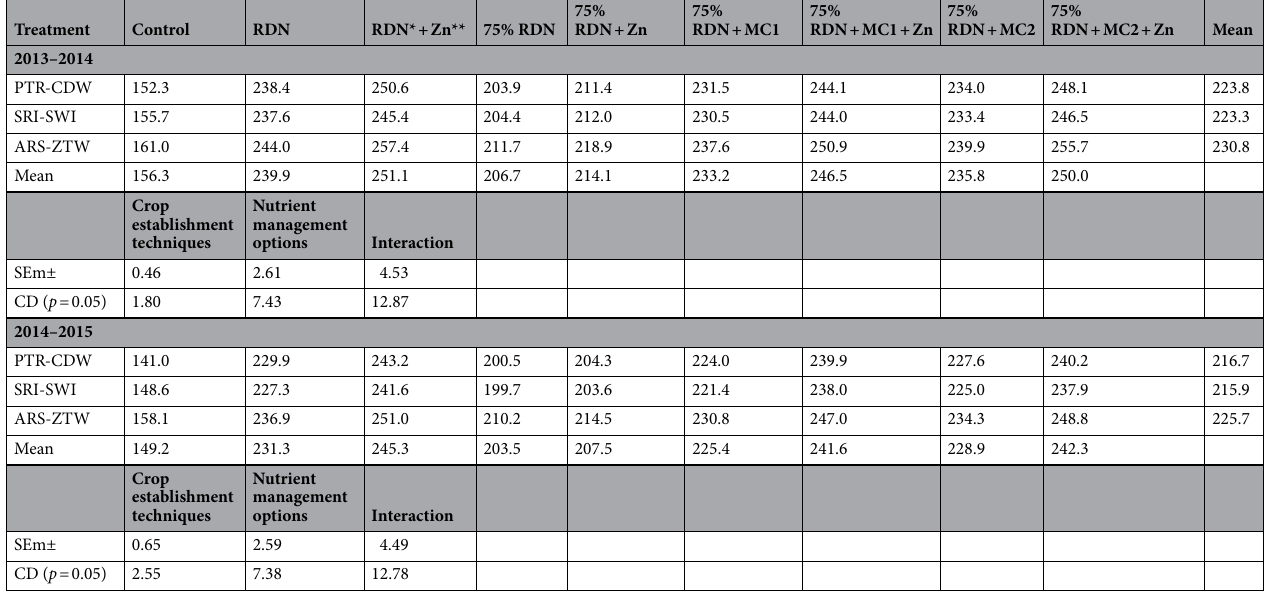
Table 4. Influence of crop establishment techniques and nutrient management options on potassium uptake (kg K ha −1 ) in rice–wheat cropping system during 2013–2014 and 2014–2015. PTR , puddled transplanted rice; SRI , system of rice intensification; ARS , aerobic rice system; CDW , conventional drill-sown wheat; SWI , system of wheat intensification; ZTW , zero tillage wheat; RDN* , recommended dose of nutrients [120 kg nitrogen ha